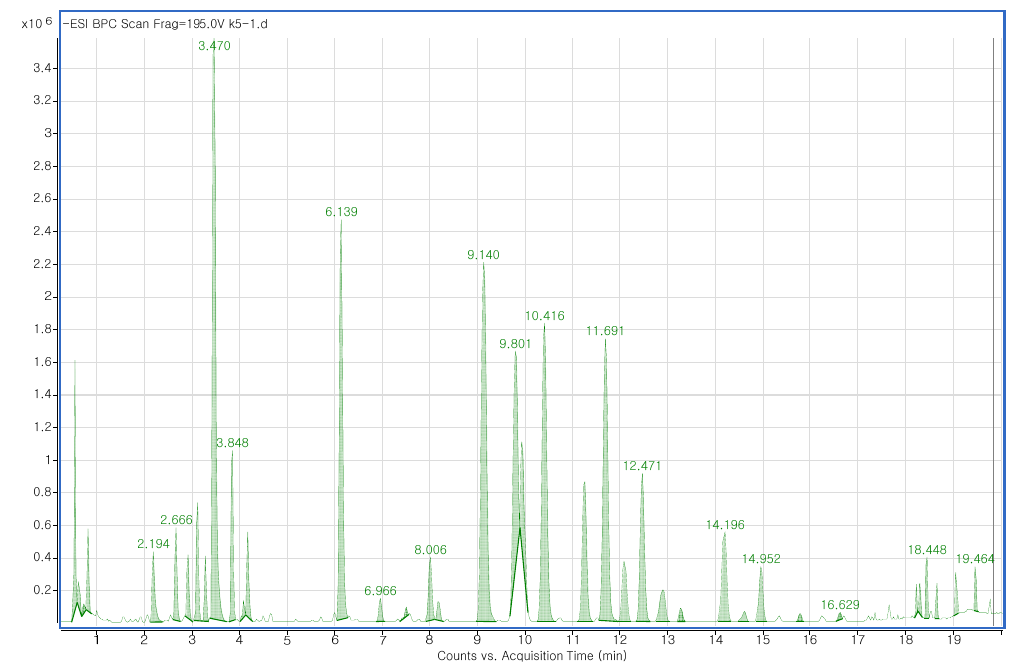
Figure 1. RRLC-QTOF/MS, ESI − base peak intensity (BPI) chromatogram of Panax ginseng